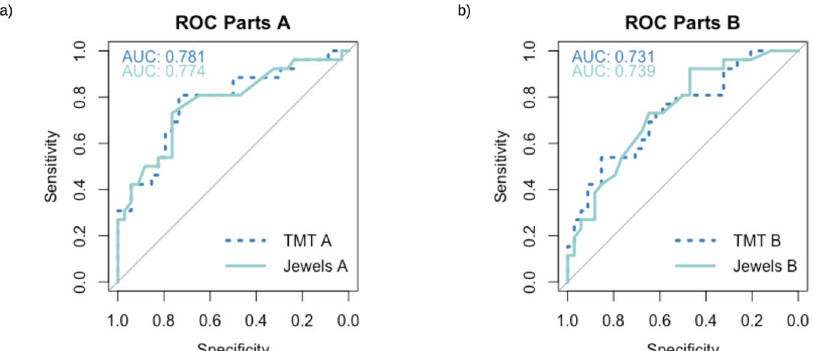
Fig. 4 Receiver operating curves results comparing the sensitivity and speci fi city for both the smartphone app JTT and pen-and-paper TMT. a JTT A and TMT A show similar sensitivity and speci fi city; b JTT B and TMT B show similar sensitivity and speci fi city. ROC receiver operating characteristic curves, AUC area under the curve, TMT Trail Making Test, JTT Jewels Trail